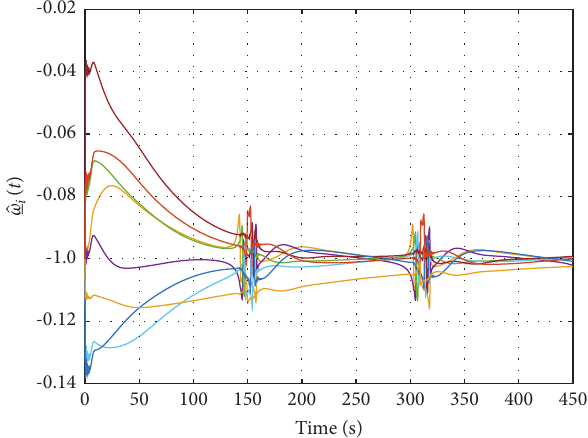
Figure 9: The estimation of lower bound disturbances 􏽢 δ